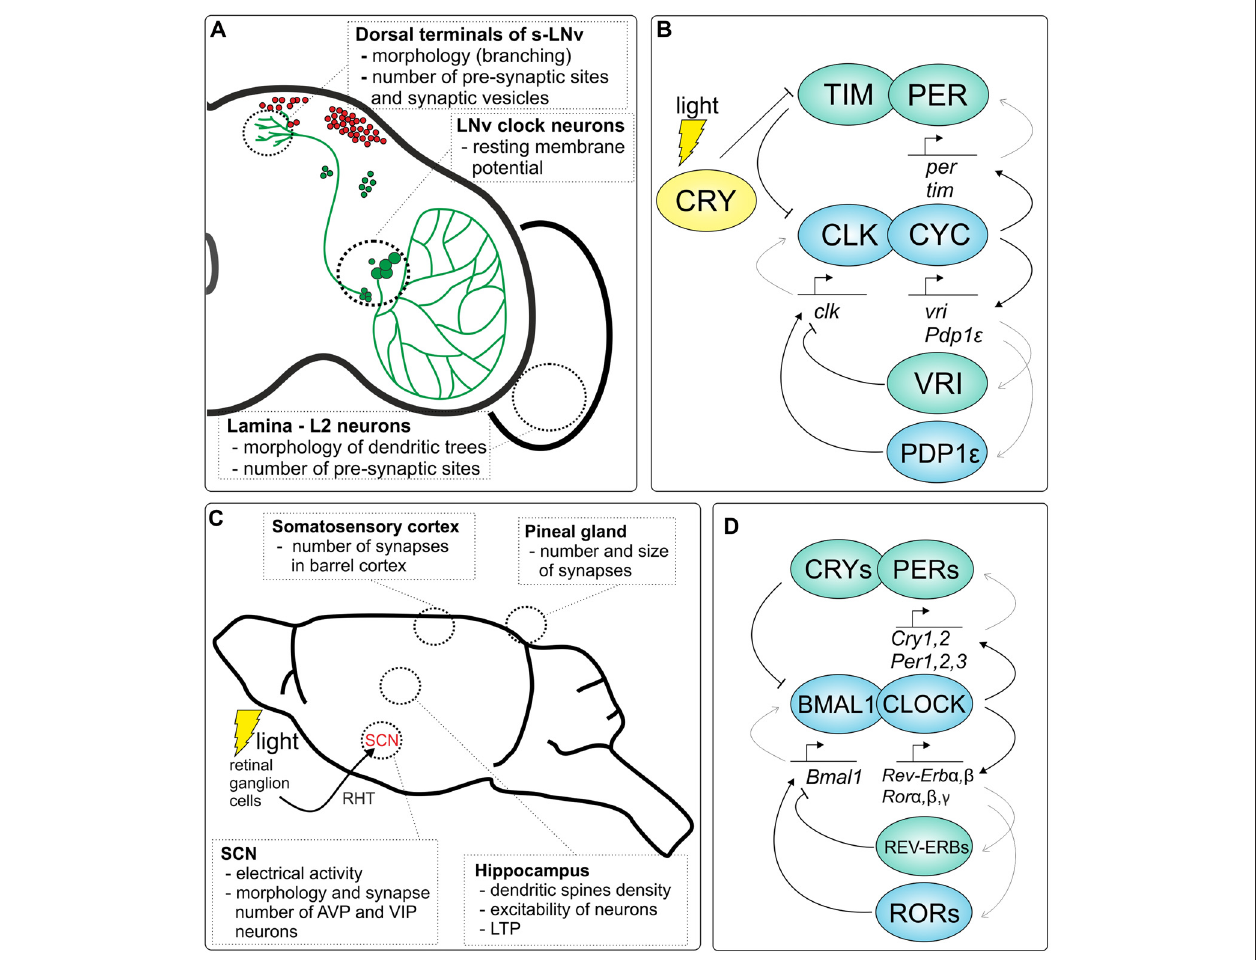
FIGURE 1 | Clock-dependent plasticity in the brain of Drosophila and rodents. (A) Examples of circadian plasticity in the Drosophila brain. The localization of DN1–3 clock neurons in the brain is shown in red, while lateral clock neurons and their pigment-dispersing factor (PDF)-positive projections are depicted in green. (B) Molecular mechanism of the fruit fly circadian clock. Two major transcriptional/translational feedback loops are shown, which are regulated by the CLOCK/CYCLE (CLK/CYC) dimer, TIMELESS/PERIOD (TIM/PER) and VRILLE/PAR DOMAIN PROTEIN 1 ε (VRI/PDP1 ε ) loops (activators are marked in blue, while inhibitors are green). Light-activated CRYPTOCHROME (CRY) protein binds TIM to initiate proteasomal degradation which allows to synchronize the clock to external light conditions. (C) A schematic representation of the rodent brain with examples of circadian plasticity in different structures of the brain. The clock in the suprachiasmatic nucleus (SCN) is synchronized by light through the retina; mainly photosensitive retinal ganglion cells (melanopsin cells) are involved in clock light perception via the retinohypothalamic tract (RHT). (D) Molecular clock in mammals. Two major transcriptional/translational feedback loops, PER/CRY and REV-ERB/ROR, are regulated by the CLOCK/BMAL1 dimer (activators are marked in blue, while inhibitors are